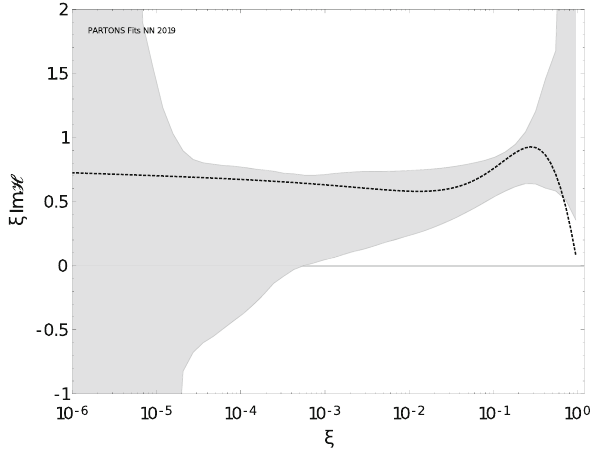
Fig. 10 Example outcome of the feasibility test. The imaginary part of the CFF H evaluated from GK GPD model [27–29] (dotted line) and the corresponding parameterization of that quantity extracted from the pseudo-data generated with this model (gray band). The plot is shown for Q 2 = 2 GeV 2 and t = − 0 . 3 GeV